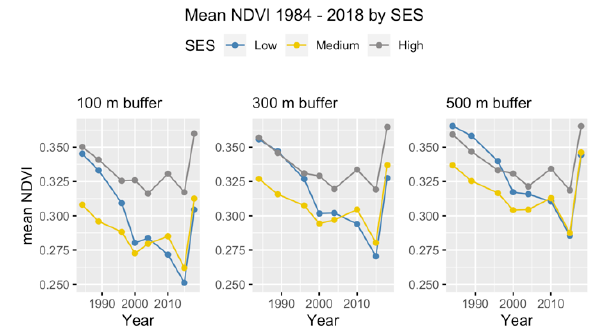
Figure 8. Temporal plots showing the evolution between 1984 and 2018 of the average value of mean NDVI by SES class at different buffer